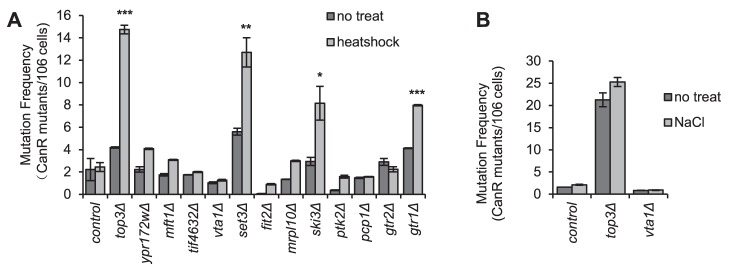
Stress-induced mutation rate in strains with SG defects.The indicated mutant strains, selected for having strongly reduced ability to accumulate SGs (Fig. 2, Fig. S4) were shocked by either heat or NaCl. The frequency of CanR cells was recorded thereafter as detailed in Materials and Methods, and compared to the mutation frequency of untreated cells of the same strain. A) Mutation rate after heat shock (44°C for 1 h). Statistically significant increases in heat-induced mutation rate in mutants compared to wt are marked with the respective numbers of stars. P values are listed in Table S3. B) Mutation rate after NaCl shock (1.5 M for 1 h). Data are mean ± standard error of measurement of three independent determinations.